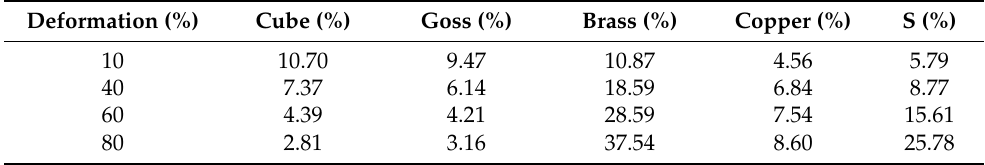
Figure 8. Sections ( ϕ = 0 ◦ ) of ODFs on the pre-annealed samples after different cold rolling treatments: ( a ) 10%; ( b ) 40%; ( c ) 60%; ( d ) 80%. Table 2. Volume fractions of the textures in pre-annealed samples after different cold rolling treatments, calculated using the ODF (with a measurement accuracy of 0.05%).